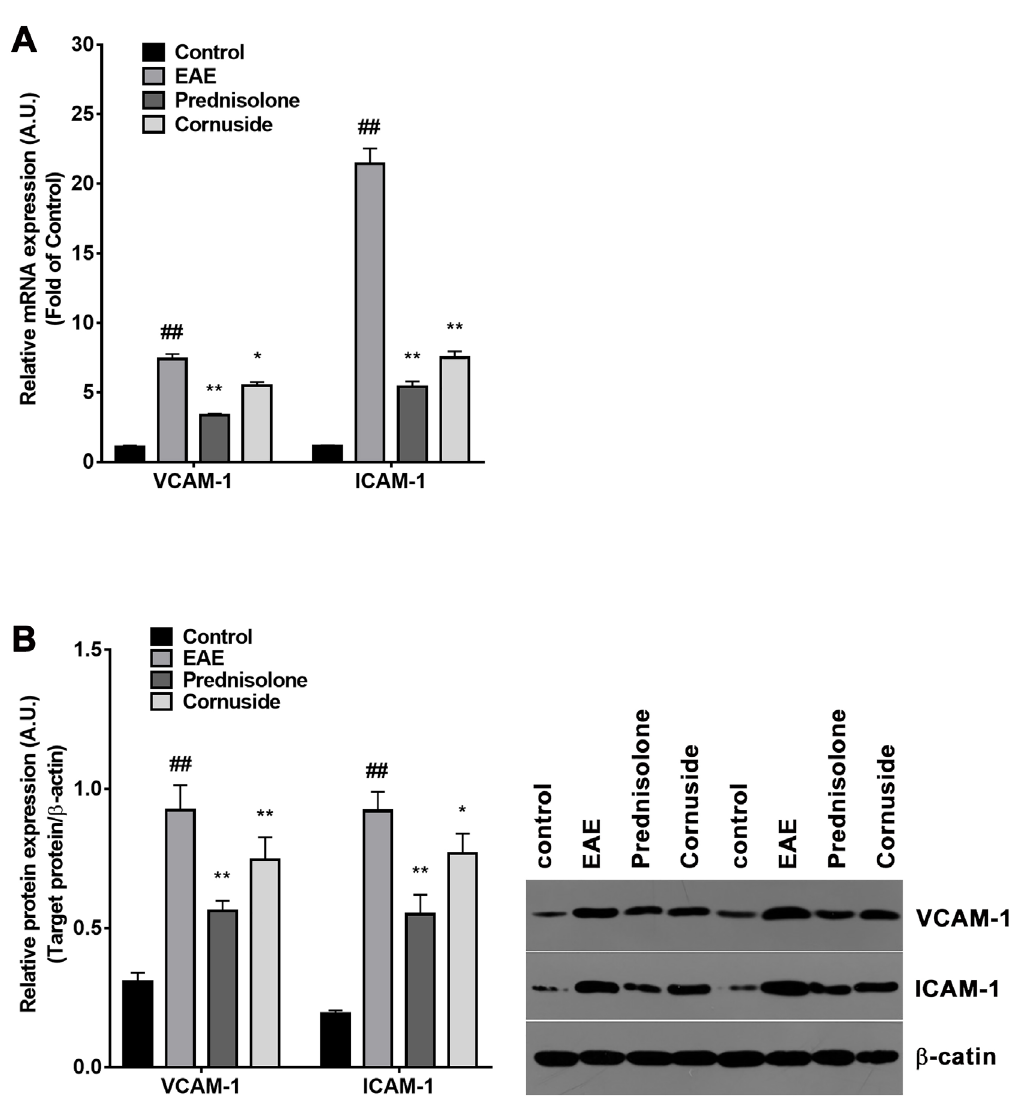
FIGURE 3 - Cornuside inhibited mRNA and protein expression of vascular cell adhesion molecule-1 (VCAM-1) and intercellular adhesion molecule-1 (ICAM-1) in the spinal cord (SC). VCAM-1 and ICAM-1 mRNA expressions in the SC were analyzed using real-time quantitative PCR, with 18s rRNA as the normalization standard (A). VCAM-1 and ICAM-1 protein expressions in the SC were detected via western blotting (B), and representative blots are shown at the right panel of quantified data. A.U. means arbitrary units. * P <0.05, ** P <0.01 for the cornuside or prednisolone group versus the EAE group, ## P <0.01 for the EAE group versus the control